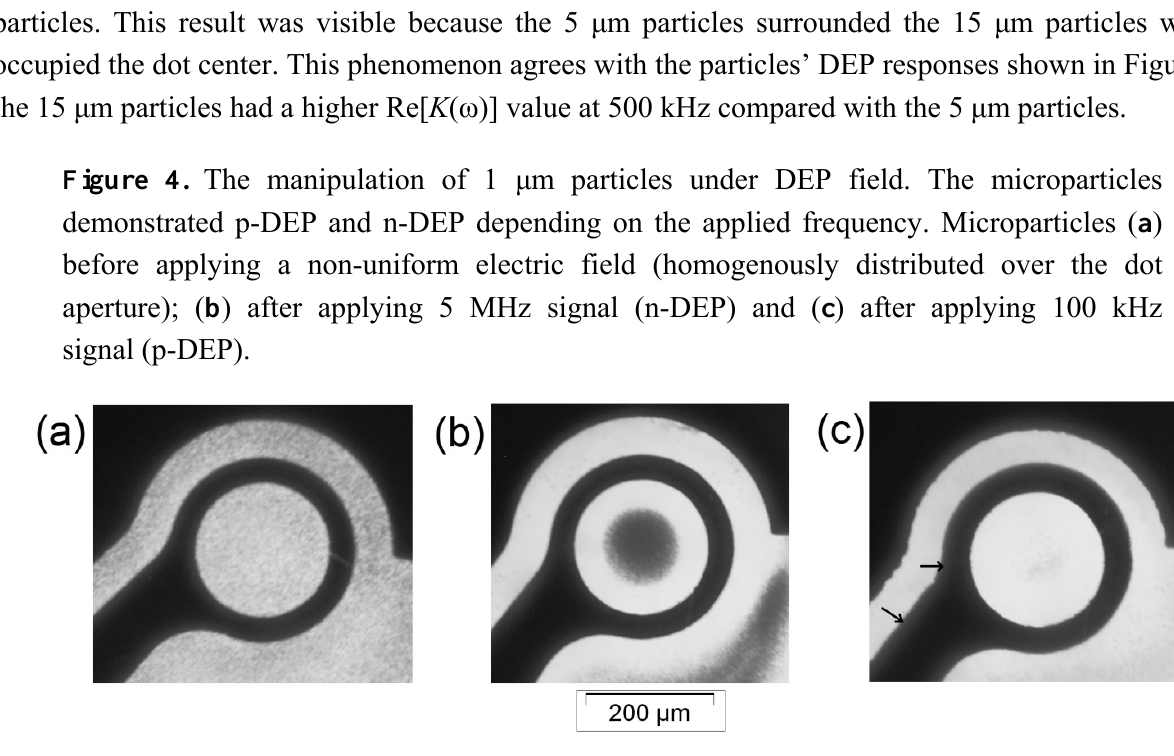
Figure 5. The manipulation of 5 and 15 μ m particles under DEP field. The figure shows 5 μ m particles (seen as the black points) and 15 μ m particles (seen as the white circles) ( a ) before applying a non-uniform electric field (both sizes of microparticles were homogenously mixed and uniformly distributed) and ( b ) after applying 500 kHz signal (n-DEP on both